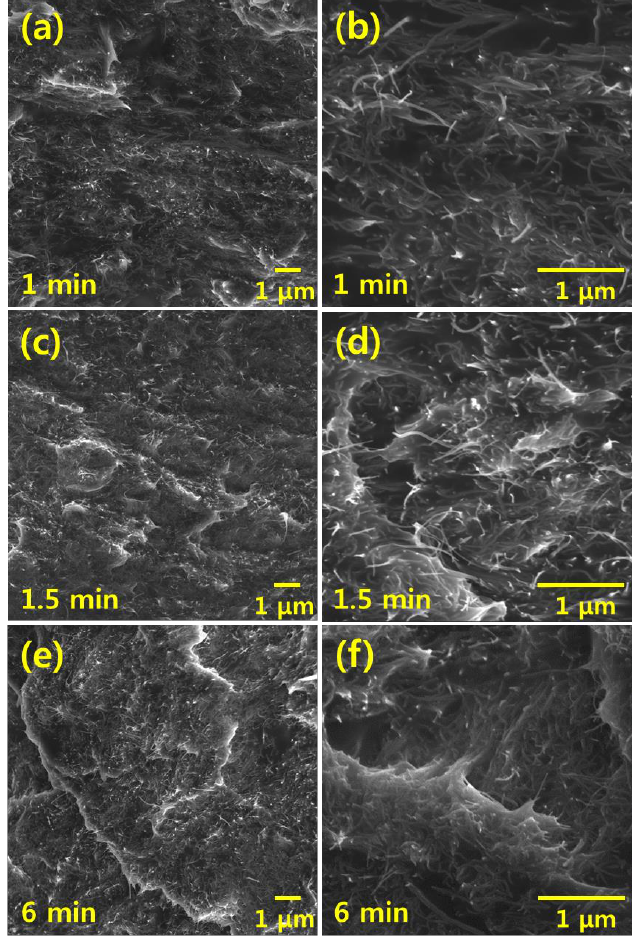
Figure 5. SEM images showing morphology of CNT/PDMS composites fabricated using three-roll milling for ( a ), ( b ) 1 min, ( c ), ( d ) 1.5 min, and ( e ), ( f ) 6 milling for ( a ), ( b ) 1 min, ( c ), ( d ) 1.5 min, and ( e ), ( f ) 6 min.